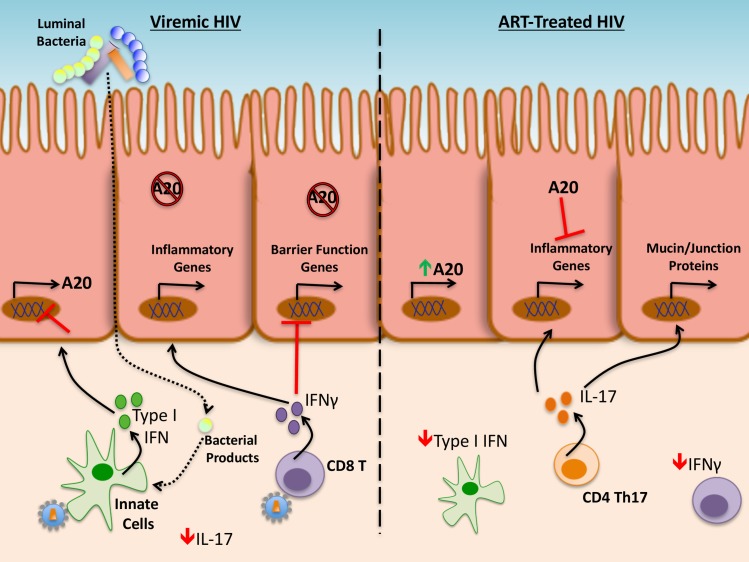
A20 modulation of epithelial function during HIV infection and treatment.Model demonstrating proposed relationship of A20 and relevant cytokines (Type I IFNs, IFNγ, and IL-17A) in the context of untreated (viremic) (left) and ART-treated (right) HIV disease.